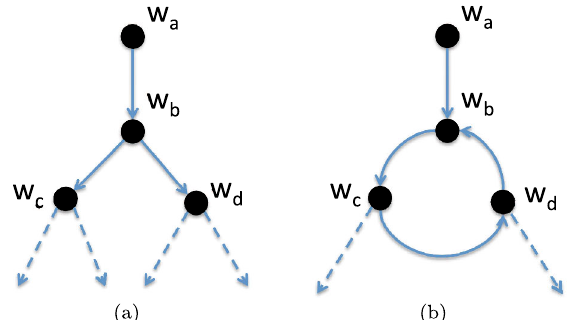
¼ f w c ; w d g , and consider the definability of